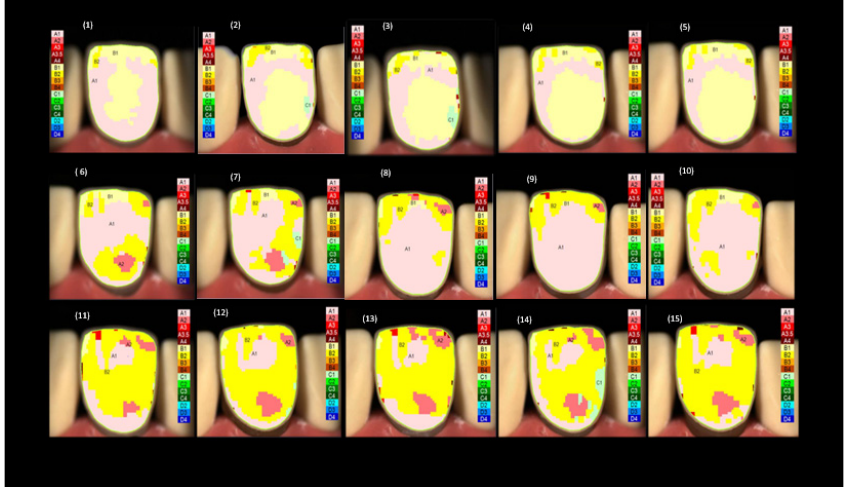
Figure 2. Representative spectrophotometer images displaying the shade maps of the 15 groups of the zirconia veneers with 0.5 mm, 0.75 mm, and 1.0 mm thickness over A1, A2, A3, A3.5, and A4 background